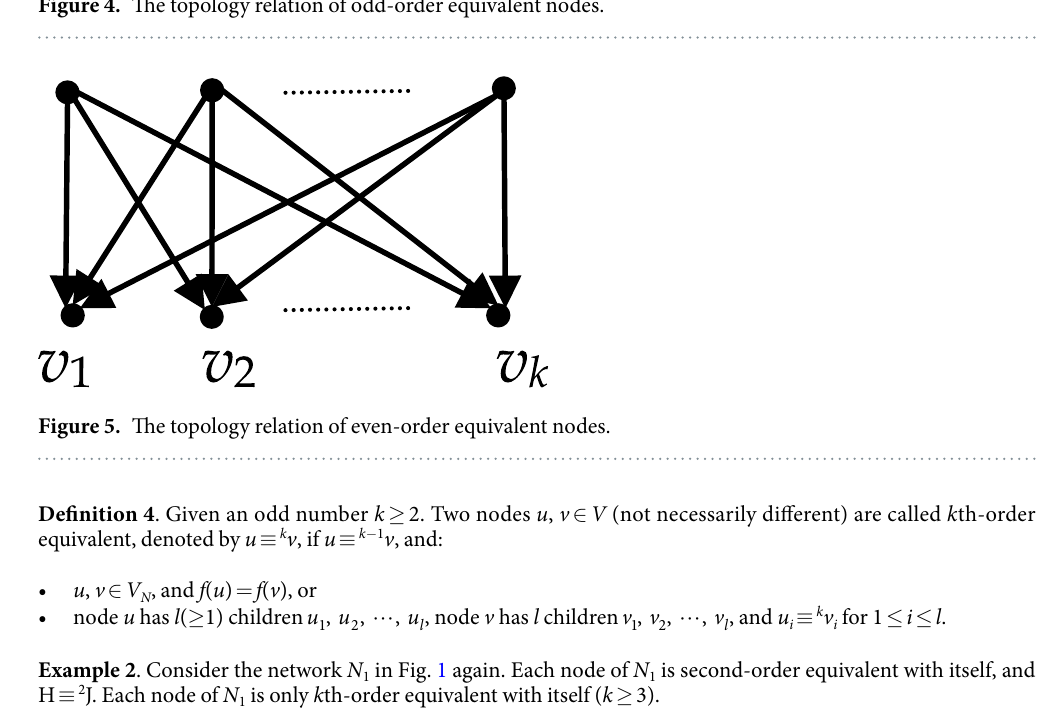
Figure 4. The topology relation of odd-order equivalent nodes.